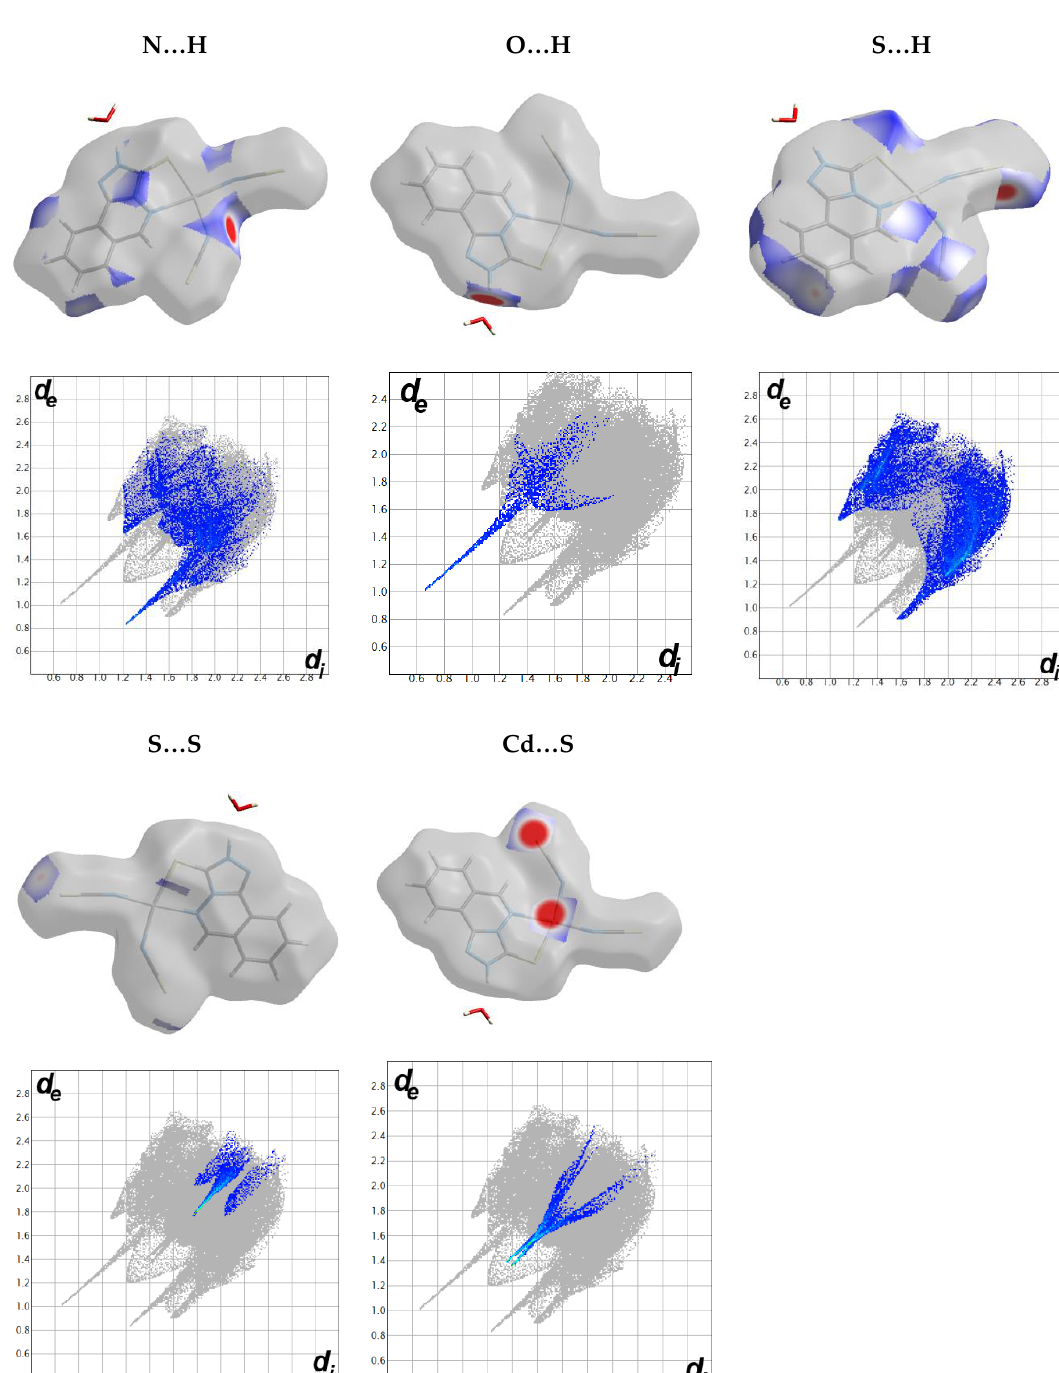
Figure 13. The decomposed fingerprint plots and d norm maps of the most important contacts in complex 2 . The most important contacts as concluded from the Hirshfeld surface analysis shared in molecular packing of complex 3 are shown in Figure 14. It is clear that the Cl…H and O…H contacts are the most important ones. Many dark red spots in the decomposed d norm map are corresponding to the Cl…H contacts. Moreover, two sharp spikes in the corresponding decomposed fingerprint plot are provide strong evidence to support the importance of these intermolecular interactions. The percentage of the Cl…H interactions is 43.5% and the shortest contact distances are 2.302, 2.376, and 2.461 Å for the Cl3…H5B,